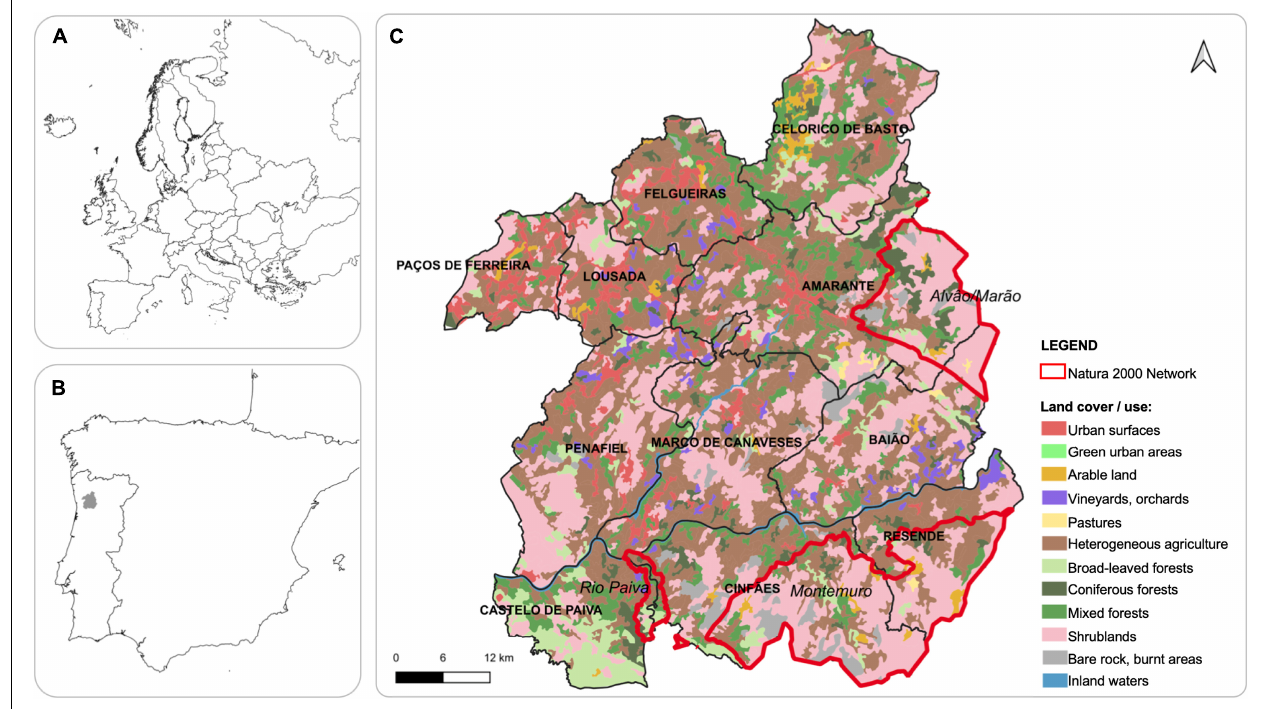
FIGURE 1 | Geographical location of the study region, the Inter-municipal Community of Tâmega and Sousa (PT11C NUTS 3 region), at the European (A) , Portuguese (B) and sub-national (C) contexts. The figure also shows the prevailing land cover/use classes, as well as the limits of the protected areas in the study region: “Alvão/Marão”, “Montemuro”, and “Rio Paiva” (Natura 2000 Network). Spatial data obtained from the Portuguese Geographic Information System (available at: https://snig.dgterritorio.gov.pt).